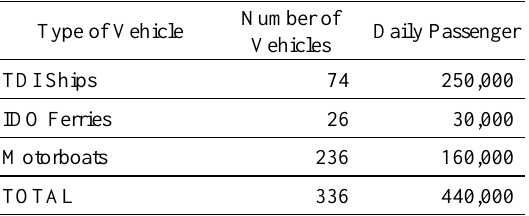
Table 3. The distribution of sea transportation.